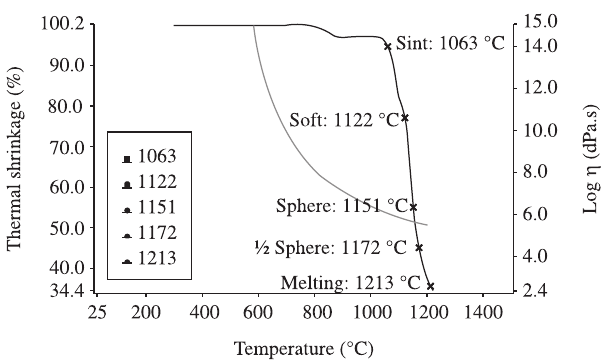
Figure 3. Viscosity behavior of the glass.